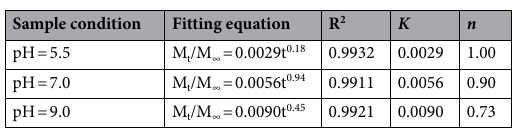
Table 2. Ritger-Peppas fitting results of Av-NDs release in